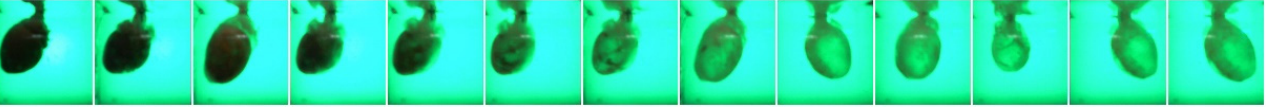
Figure 5. Serial photos were collected from the beginning to the end of the decellularization process. The macroscopic images of the rat heart show the myocardial tissue’s changes. The very end moment of decellularization could not be settled with the human eye, being impossible to pick the differences between the last photos.